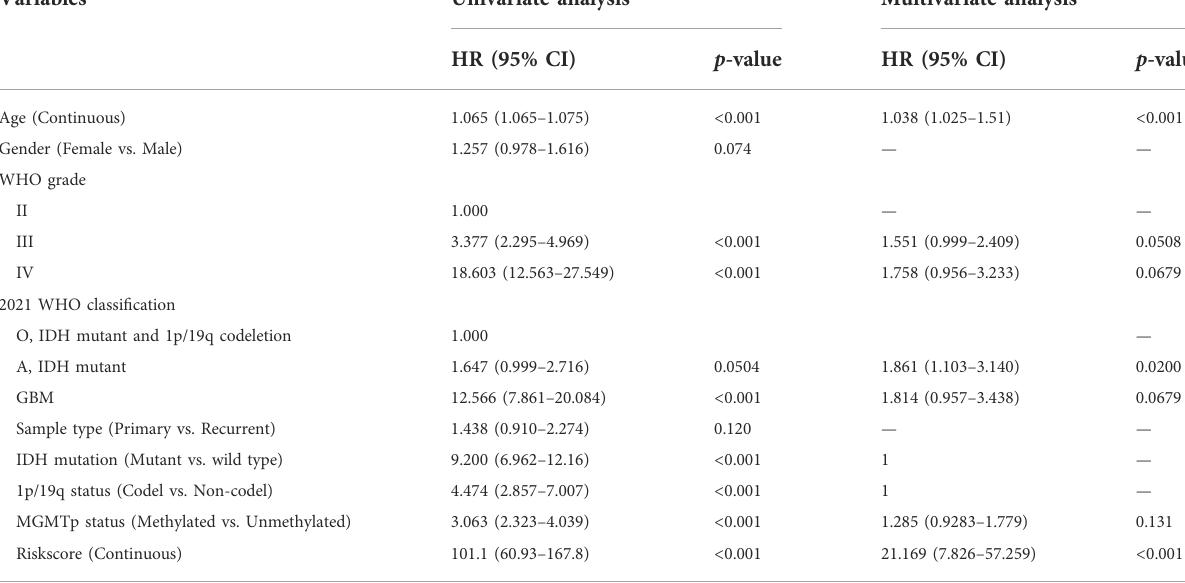
TABLE 2 Univariate and multivariate Cox analyses in the TCGA, CGGA_693, and CGGA_325 cohorts.